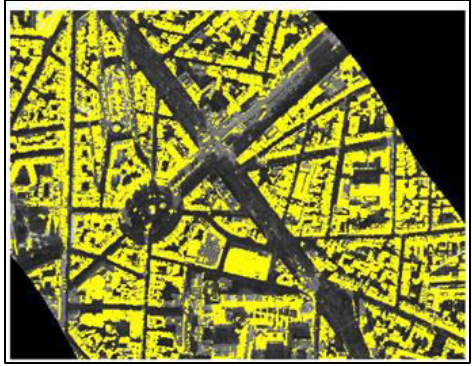
Figure 7. Generation of vector map of buildings (i.e. object sets) identified by supervised classification.